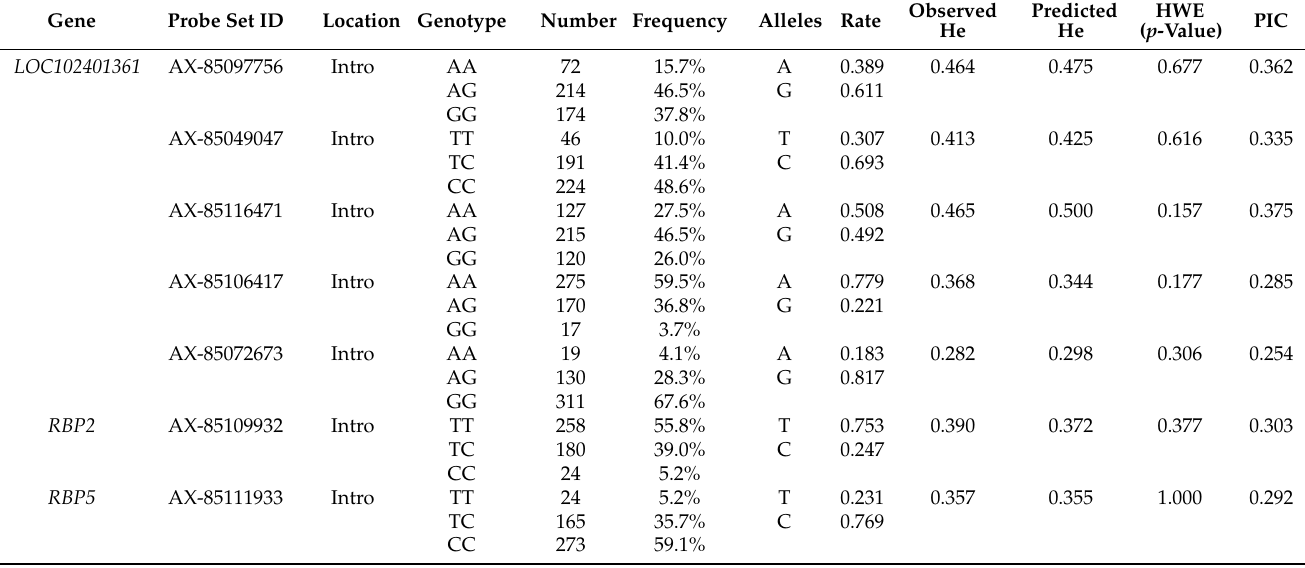
Table 4. Characterization of the SNPs within FABP genes that were genotyped in the Buffalo population of 489 individuals studied in the present work and that passed the quality control filtering.